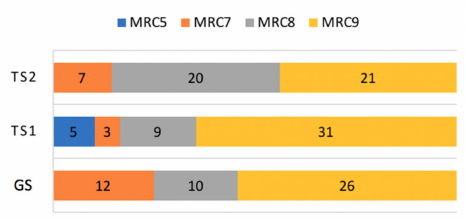
Figure 7. Composition of MRC